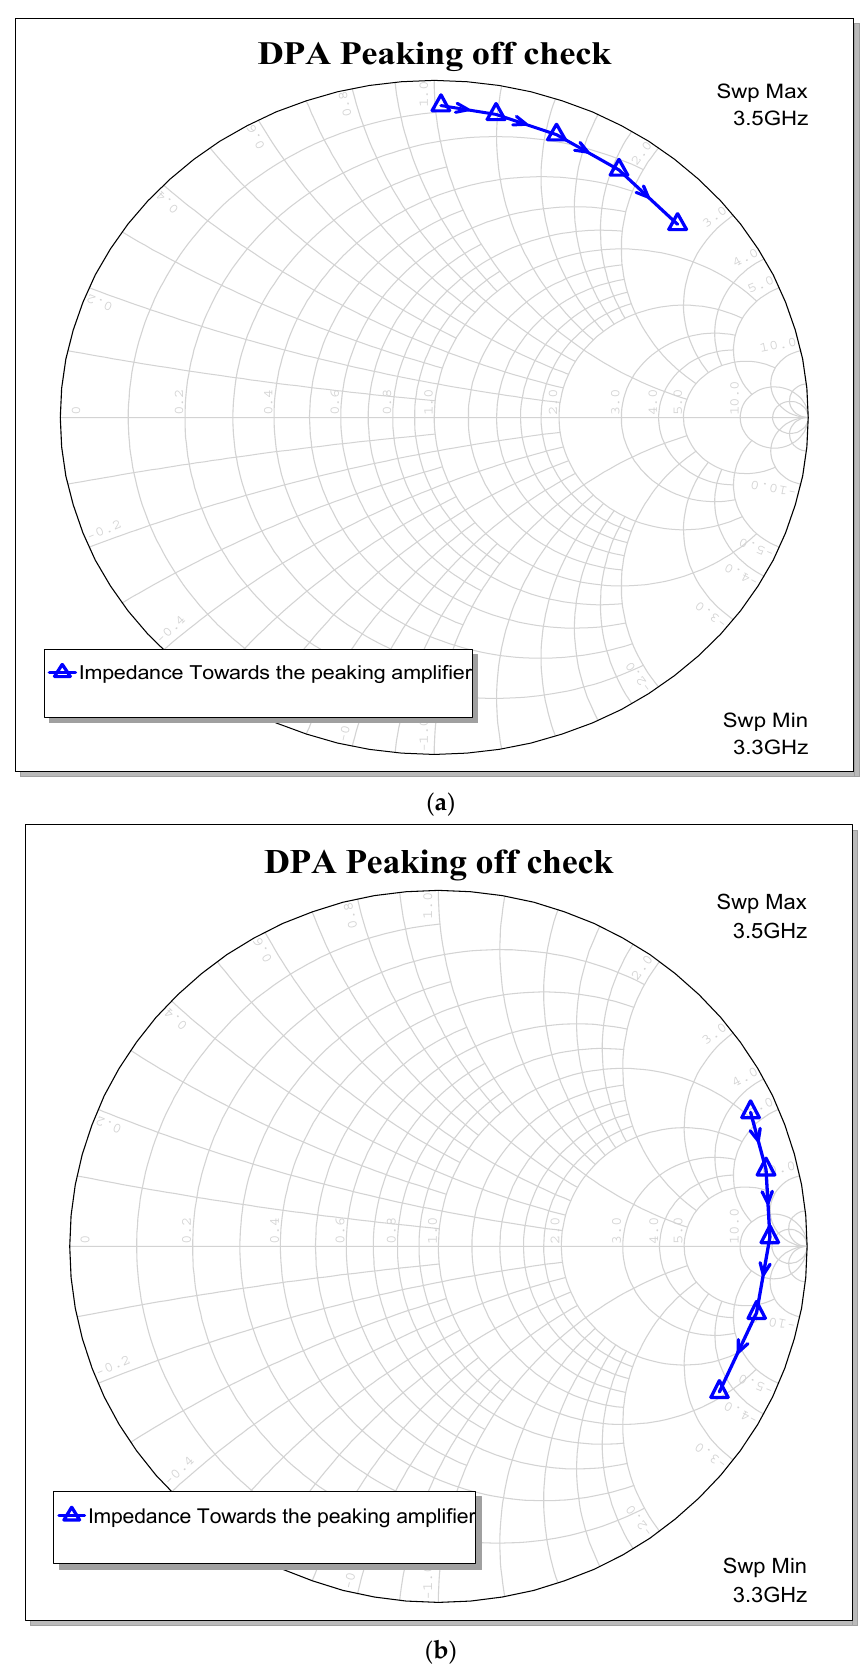
Figure 9. Impedance seen towards the auxiliary amplifier; ( a ) without adding the line-offset, ( b ) with adding the line-offset.